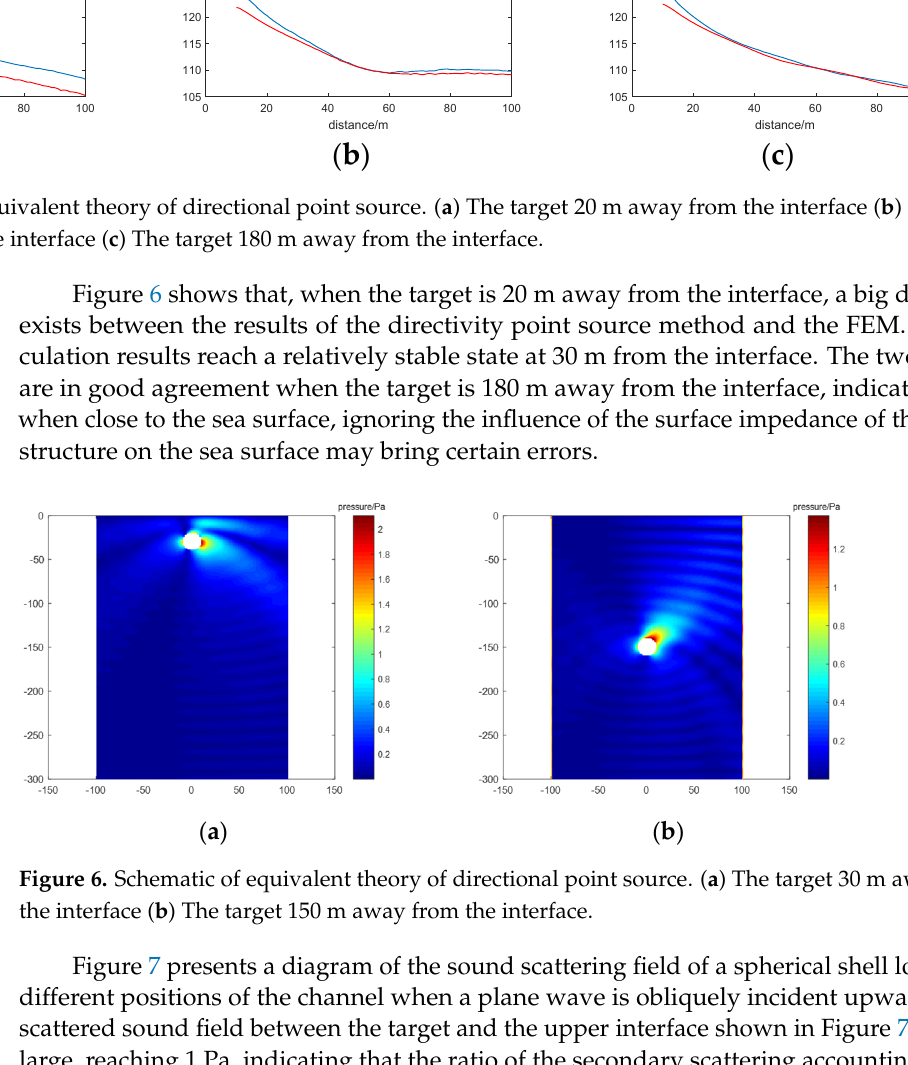
Figure 6. Schematic of equivalent theory of directional point source. ( a ) The target 30 m away from the interface ( b ) The target 150 m away from the interface